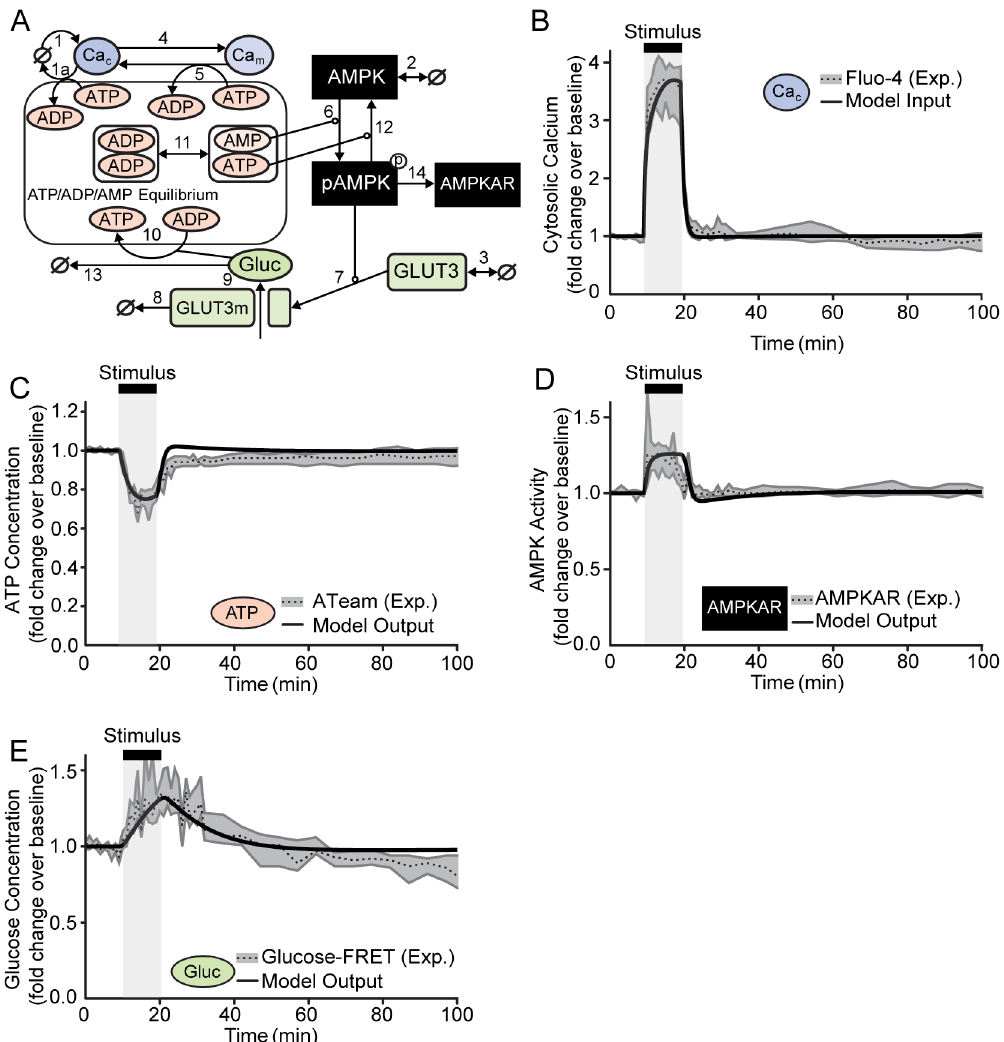
Fig 1. The computational model correctly predicted ATP, AMPK activity and glucose dynamics measured in neurons exposed to glutamate. (A) Model schematic. State variables are described in Table 1, and reaction numbers correspond to those listed in Table 2 and S1 Table. (B-E) Model input and simulations (solid black lines) overlaid on the median and inter-quartile regions (dotted black line, grey shaded area) of previously published fluorescence measurements in single cerebellar granule neurons exposed to glutamate for 10 min [15]. The time of stimulus (model input or glutamate exposure) is marked with a light grey bar. Values were normalised to baseline. (B) A transient (10 min) increase in cytosolic calcium was applied as model input (see Methods and d[Cac]/dt equation in S1 Table), and fitted to fluorescence measurements of cytosolic calcium (Fluo-4 AM) in CGNs exposed to glutamate. (C) The simulated ATP dynamics closely aligned with experimental measurements of intracellular ATP concentration [ATeam is a fluorescent reporter of intracellular ATP concentration; [16]]. (D) The simulated transient activation of AMPK resembled experimental measurements of AMPK activity [AMPKAR is a fluorescent reporter of AMPK activity [17]]. (E) The model also correctly predicted a prolonged elevation of intracellular glucose and its delayed recovery [Glucose-FRET is a fluorescent reporter of intracellular glucose concentration